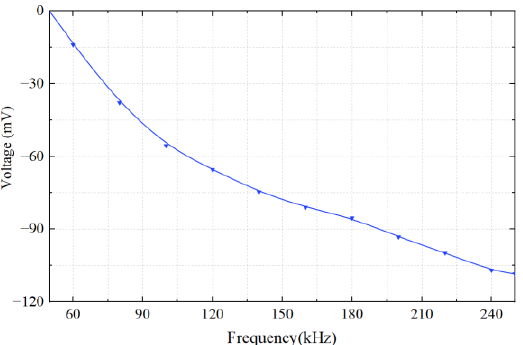
Figure 14. The relationship between the output voltage and excitation frequency of non-ferrous metal particles.